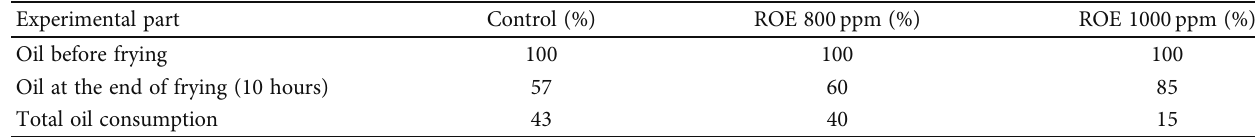
Table 2: Comparative measurement of soybean oil consumption. Experimental